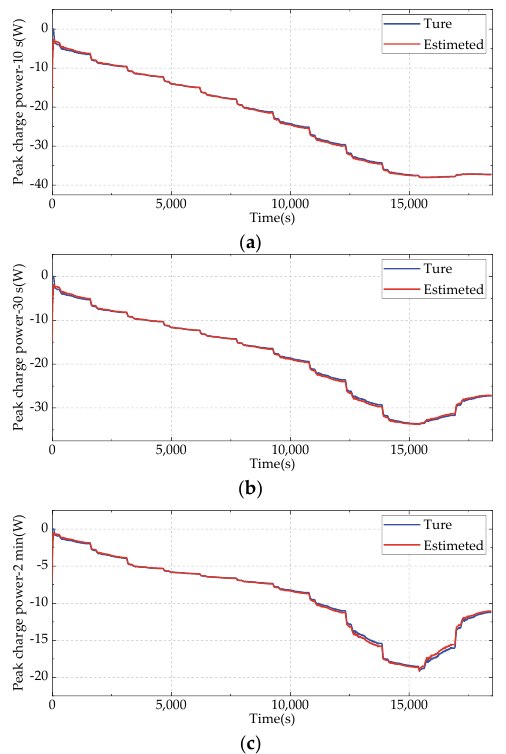
W. Figures 19 and 20 show the continuous peak charging power curves and the corre-